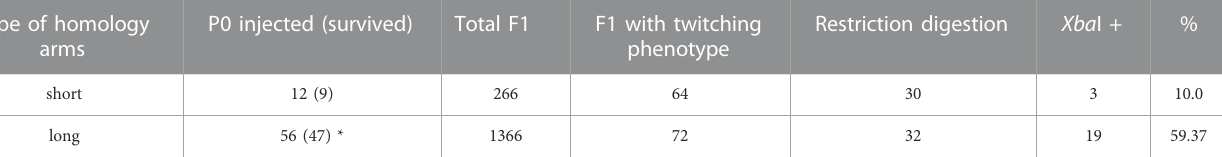
TABLE 4 Summary of injection experiments with short or long homology arms. Type of homology